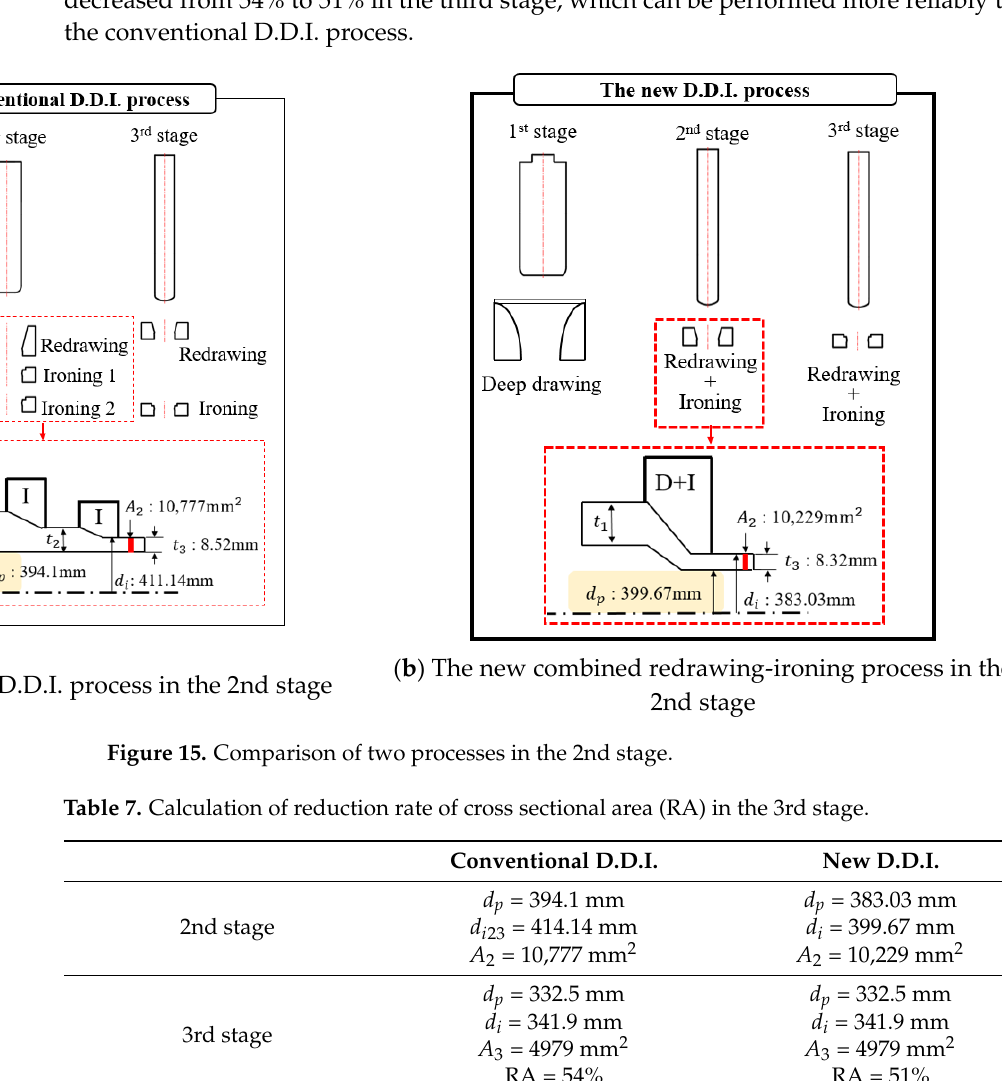
12 of 14 Figure 14. Comparison of the combined redrawing-ironing load obtained from FEA and that of theoretical formula by varying DIR. Table 5. Error between combined loads obtained from FEA and theoretical formula according to DIR. DIR